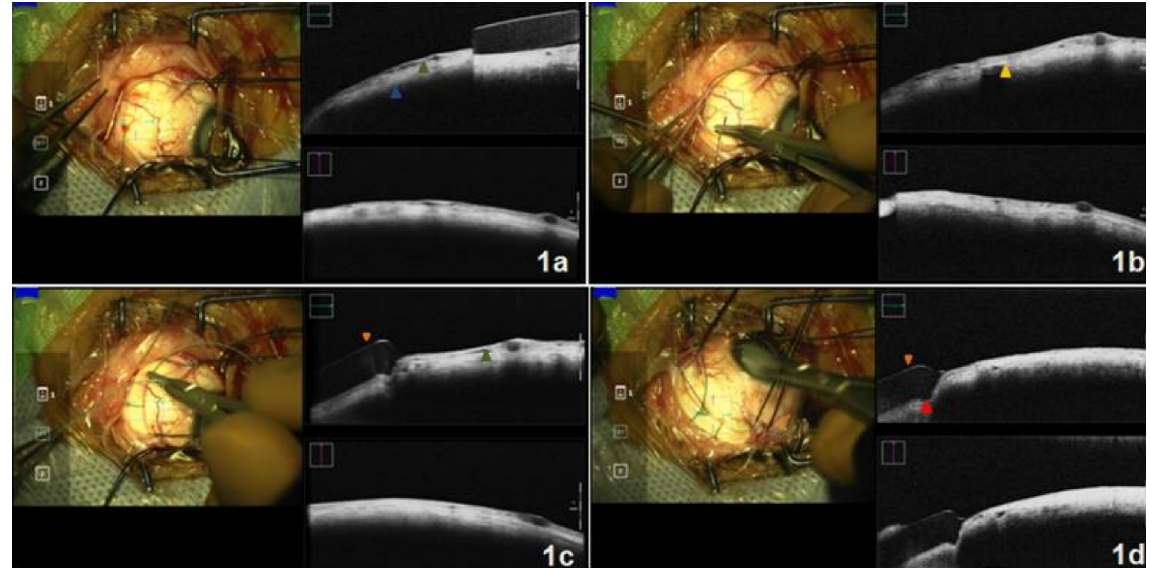
Figure 1: a) Realtime passage of suture through the sclera, seen as hyporeflective space (green arrowhead). Sclero-choroidal junction can be easily appreciated on Mi-OCT (blue arrowhead). b) Hyperreflective band with backshadowing (yellow arrowhead) corresponding to real time passage of suture needle. c) Encircling 240 band (orange arrowhead) and hyporeflective space corresponding to depth of suture tract (green arrowhead). d) Desired scleral intend (red arrowhead) achieved by tying the scleral